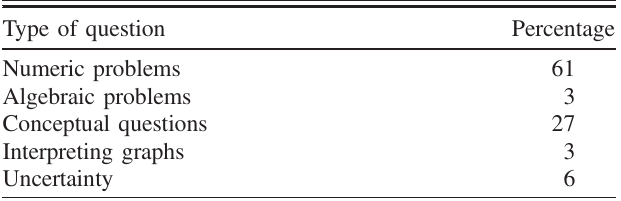
TABLE I. Types of questions on the final